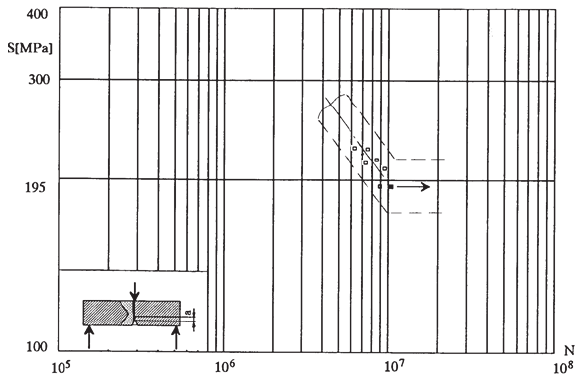
Figure 8: S-N Relationship for specimens with initial crack a= 1.125